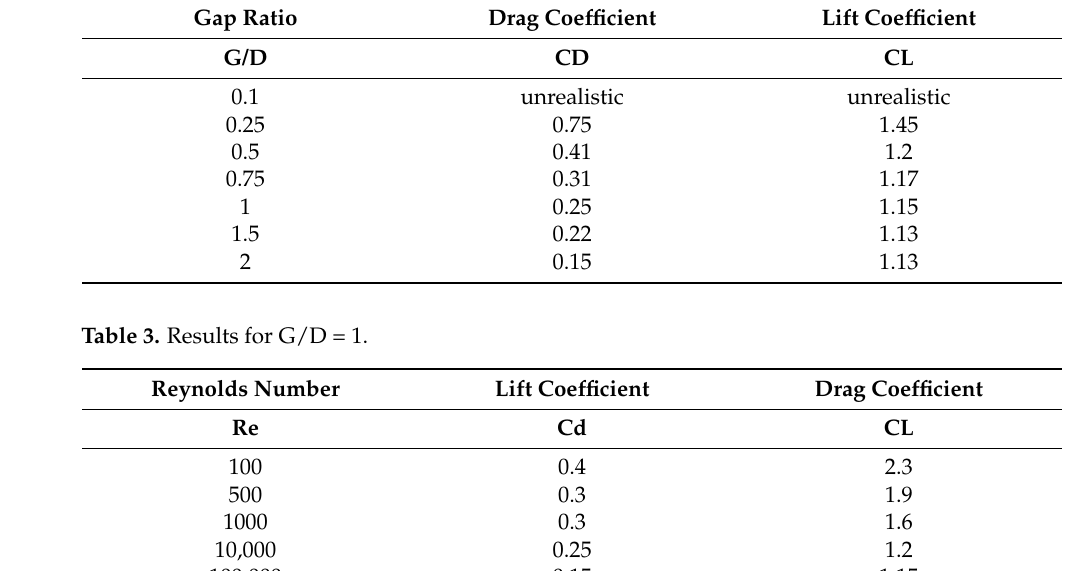
Table 2. Results for Reynolds number 100.